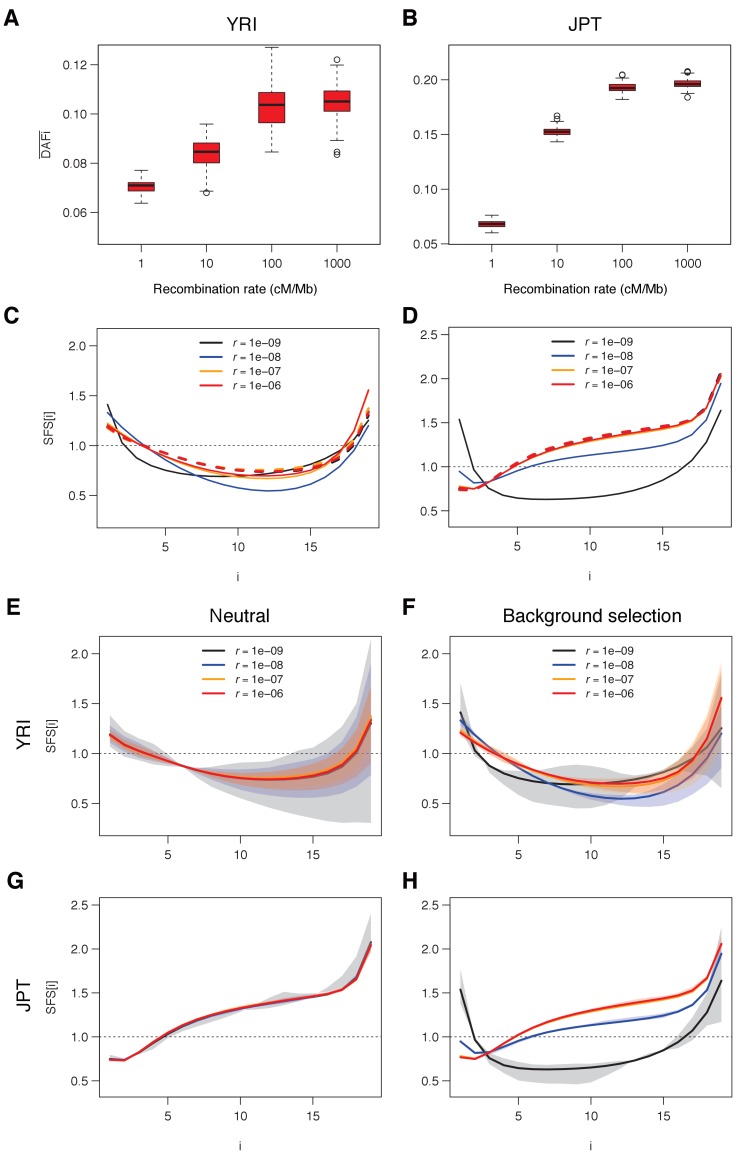
Simulated DAFi¯ and SFS under neutrality and with background selection for various recombination rates.Individual based simulations were done as described in Figure 4 and Figure 4—figure supplement 1, but with shorter alternating segments of sequence under purifying selection (100 bp instead of 1000 bp) and neutral sequence (400 bp instead of 4000 bp). (A, B) Average derived allele frequency per individual (DAFi¯). (C, D) Unfolded normalized SFS. Other details as in Figure 4. (E, F) Unfolded SFS based on the YRI demographic parameters without (E) and with (F) BGS. (G, H) Unfolded SFS based on the JPT demographic parameters without (G) and with (H) BGS. Shaded areas delimit a 95% range obtained from 100 simulations. Other details as in Figure 4—figure supplement 1. See Materials and methods for details of simulations.